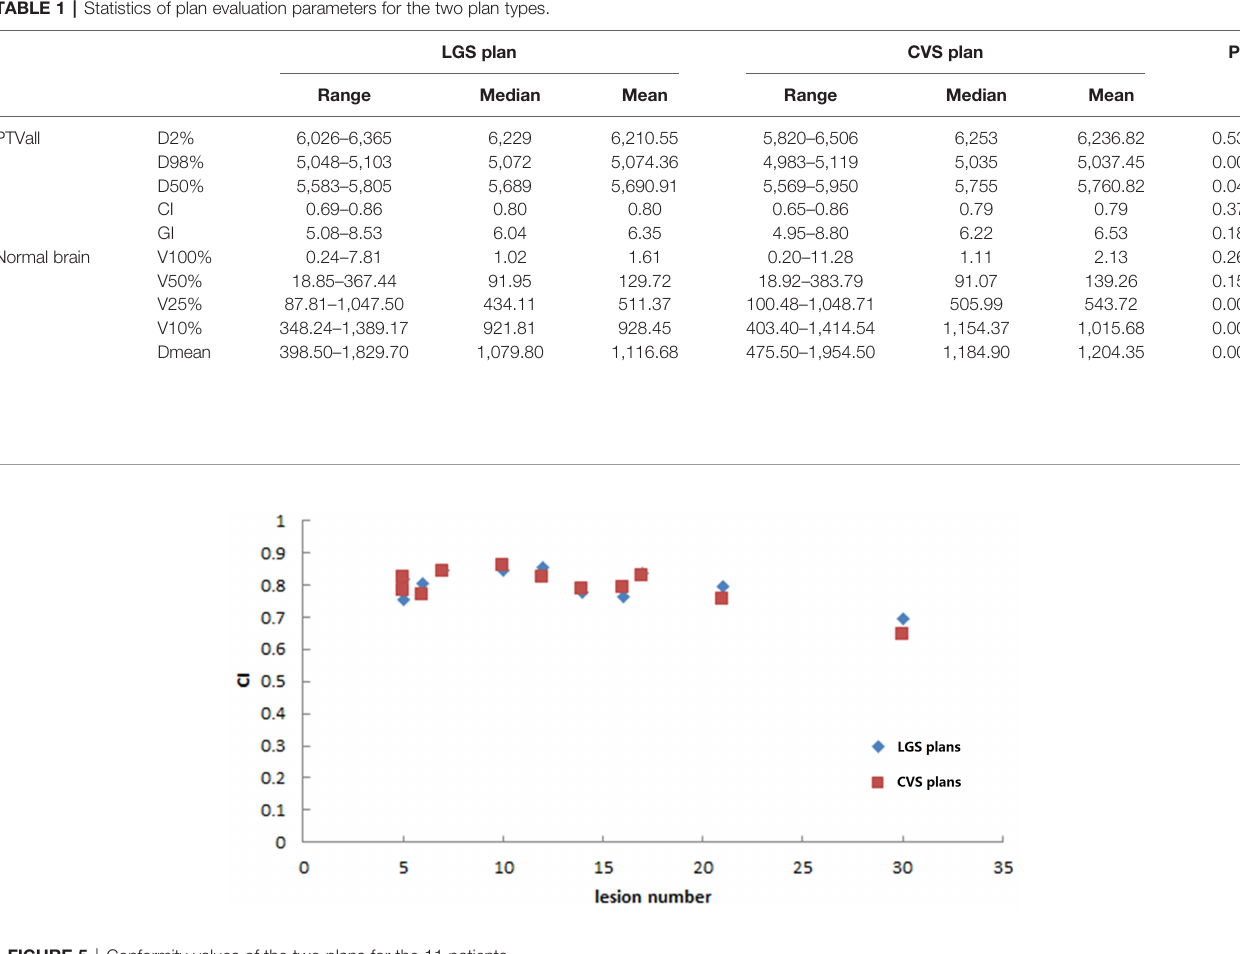
FIGURE 5 | Conformity values of the two plans for the 11